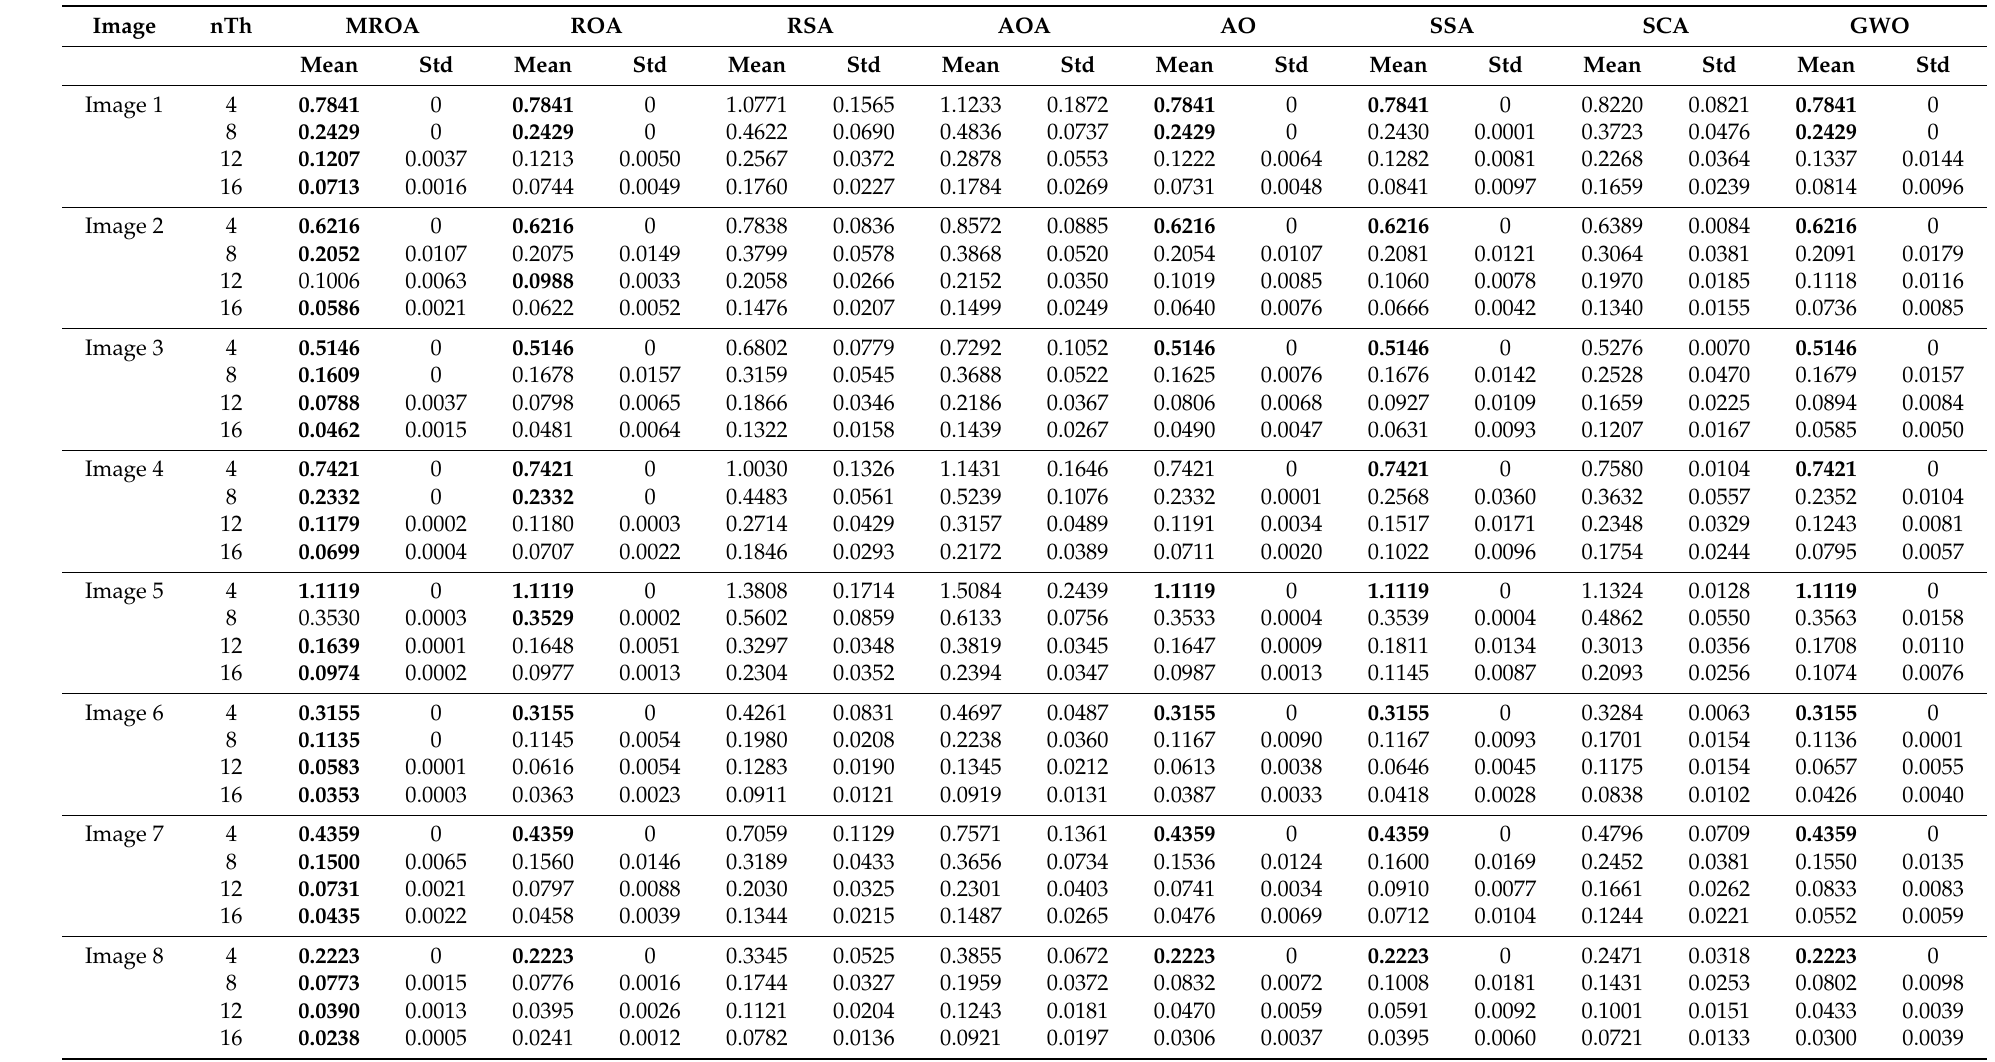
Table A3. The best fitness values obtained by algorithms over all